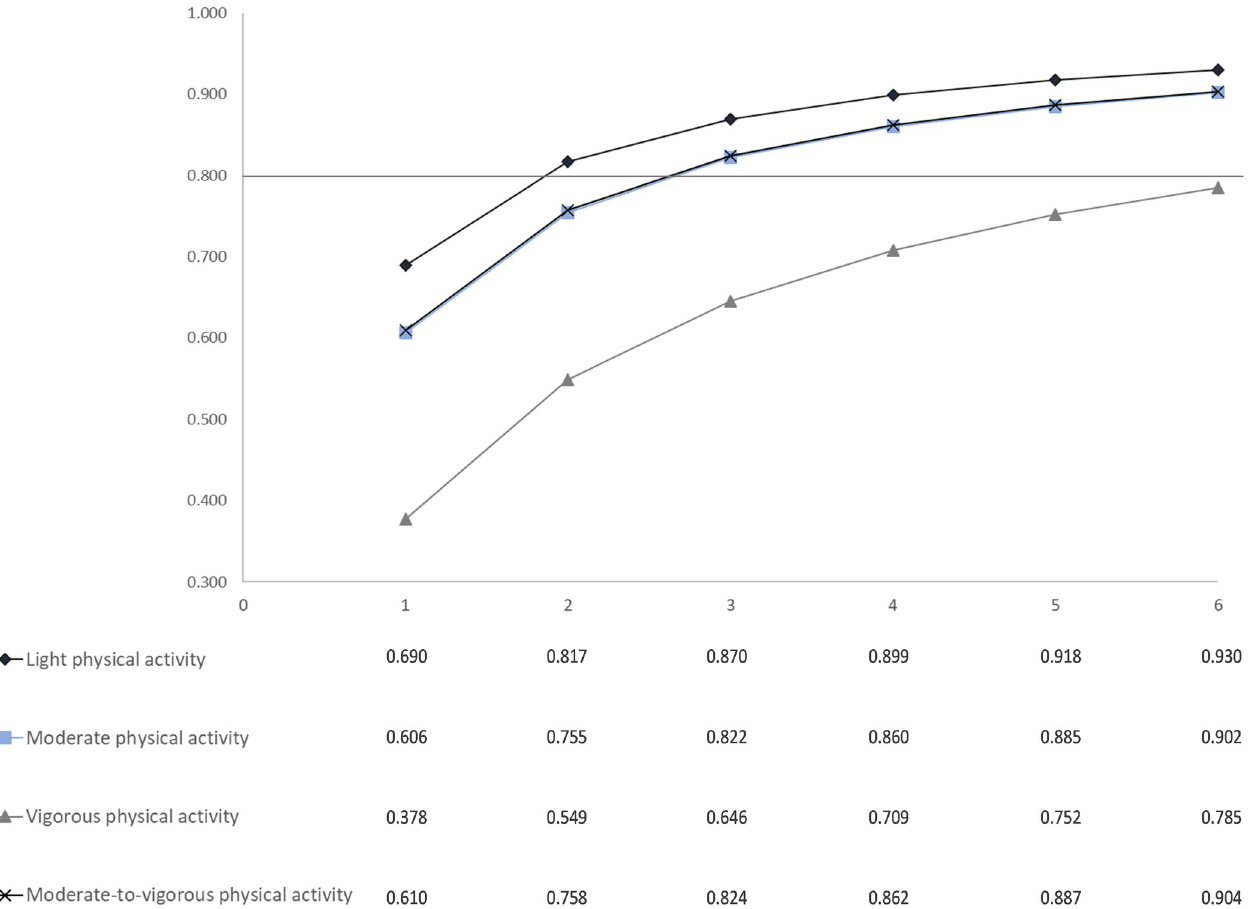
Fig 1. Number of monitoring days with the corresponding intra-class correlation coefficient (ICC) based on the Spearman Brown formula for each physical activity intensity (n = 736).